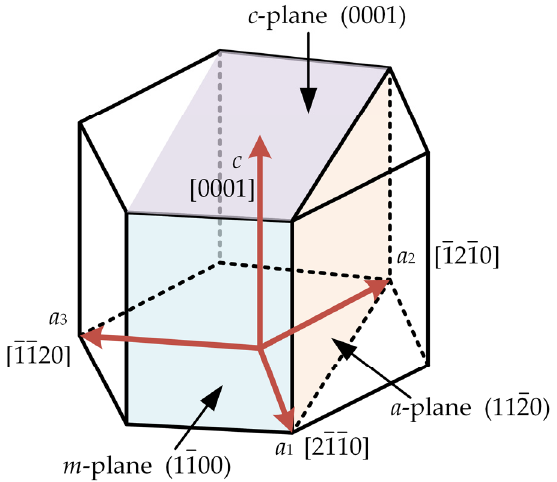
Figure 3. Schematic of the structure of wurtzite, where a 1 , a 2 , a 3 and c denote the crystal orienta- tions.